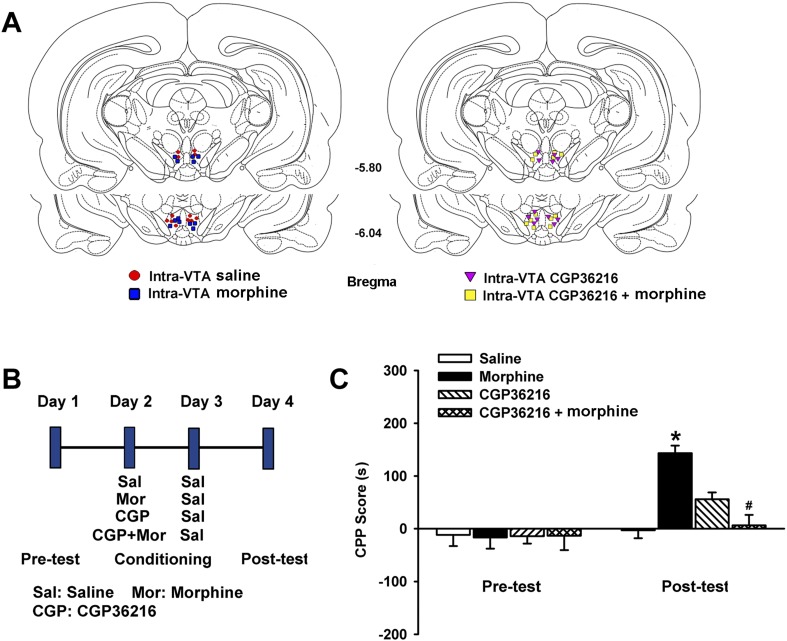
Influence of intra-ventral tegmental area (VTA) injection of the presynaptic GABAB receptor antagonist CGP36216 on intra-VTA injected morphine-induced conditioned place preference (CPP) in rats.(A) Schematic representations of injection cannula tips in the VTA of rats used in data analyses. Numbers indicate coordinates relative to bregma. (B) A schematic of the experimental design for CPP and administration of drugs. (C) Influence of the presynaptic GABAB receptor antagonist CGP36216 on morphine-induced CPP in rats. Averaged CPP score of preconditioning and postconditioning in different groups (n = 6 rats in the every group; *p < 0.05, intra-VTA injection of morphine group compared with intra-VTA injection of saline group, #p < 0.05, intra-VTA injection of morphine plus CGP36216 group compared with intra-VTA injection of morphine group). Data are shown as the mean ±s.e.m.